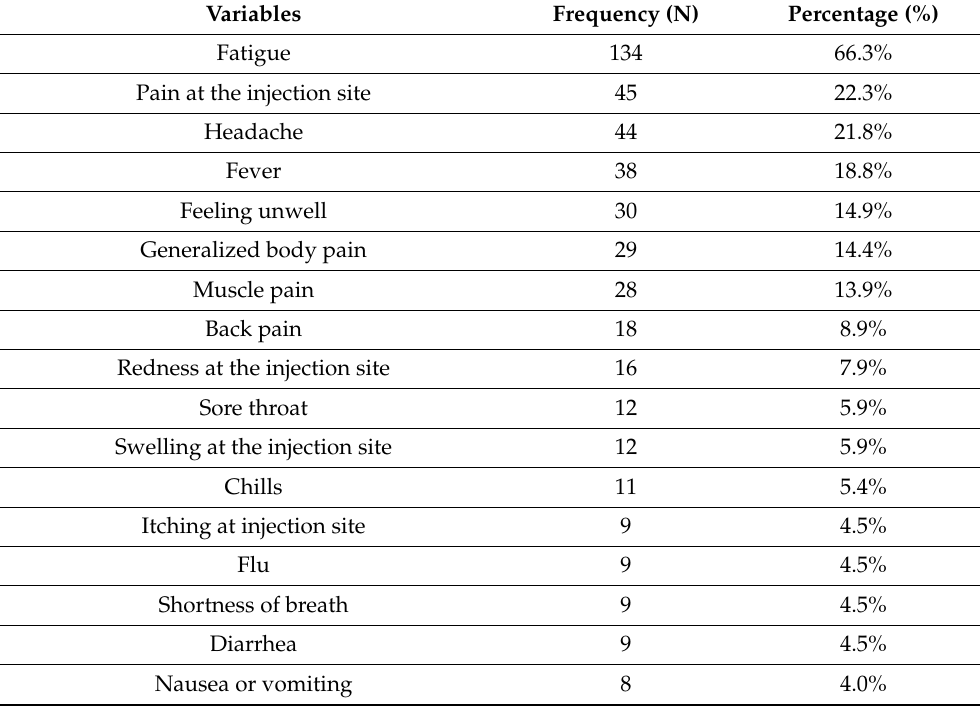
Table 5. Side-effects experienced after second dose of COVID-19 vaccines (N =